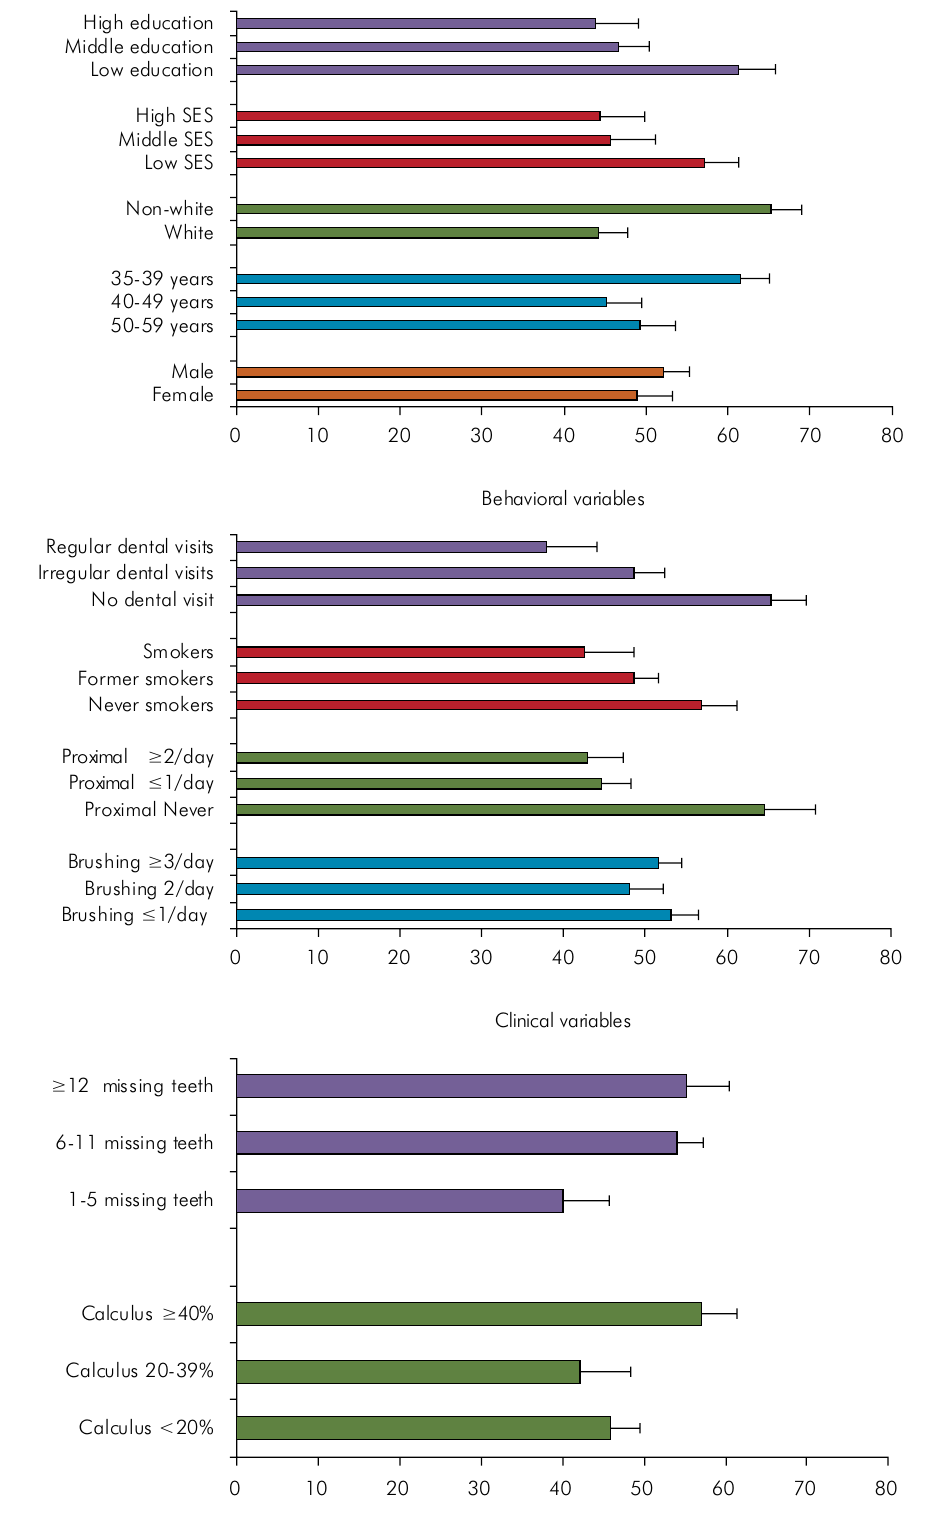
8 Braz. Oral Res.